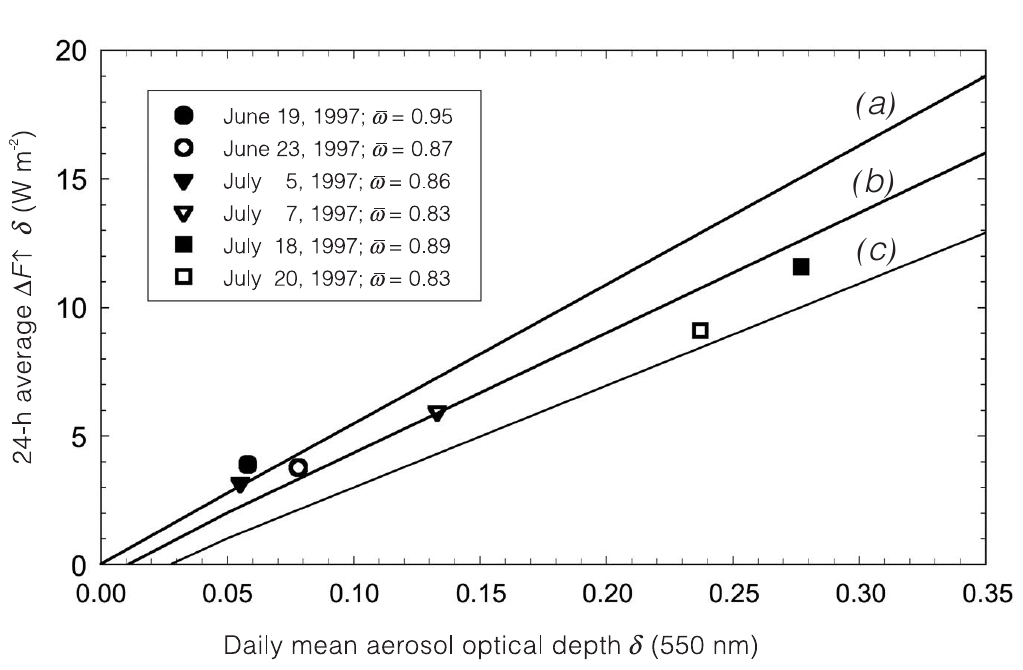
Fig. 5. Estimates of the 24-h average fl ux change D F (cid:112) determined on the six selected days as a function of the daily mean aerosol optical depth d (550 nm) and for different daily average values of the columnar aerosol single scattering albedo v . The results are compared with the relationship curves determined by Russell et al. (1999b) during the TARFOX experiment for three different values of v : ( a ) v = 1.00; ( b ) v = 0.935, and ( c ) v =